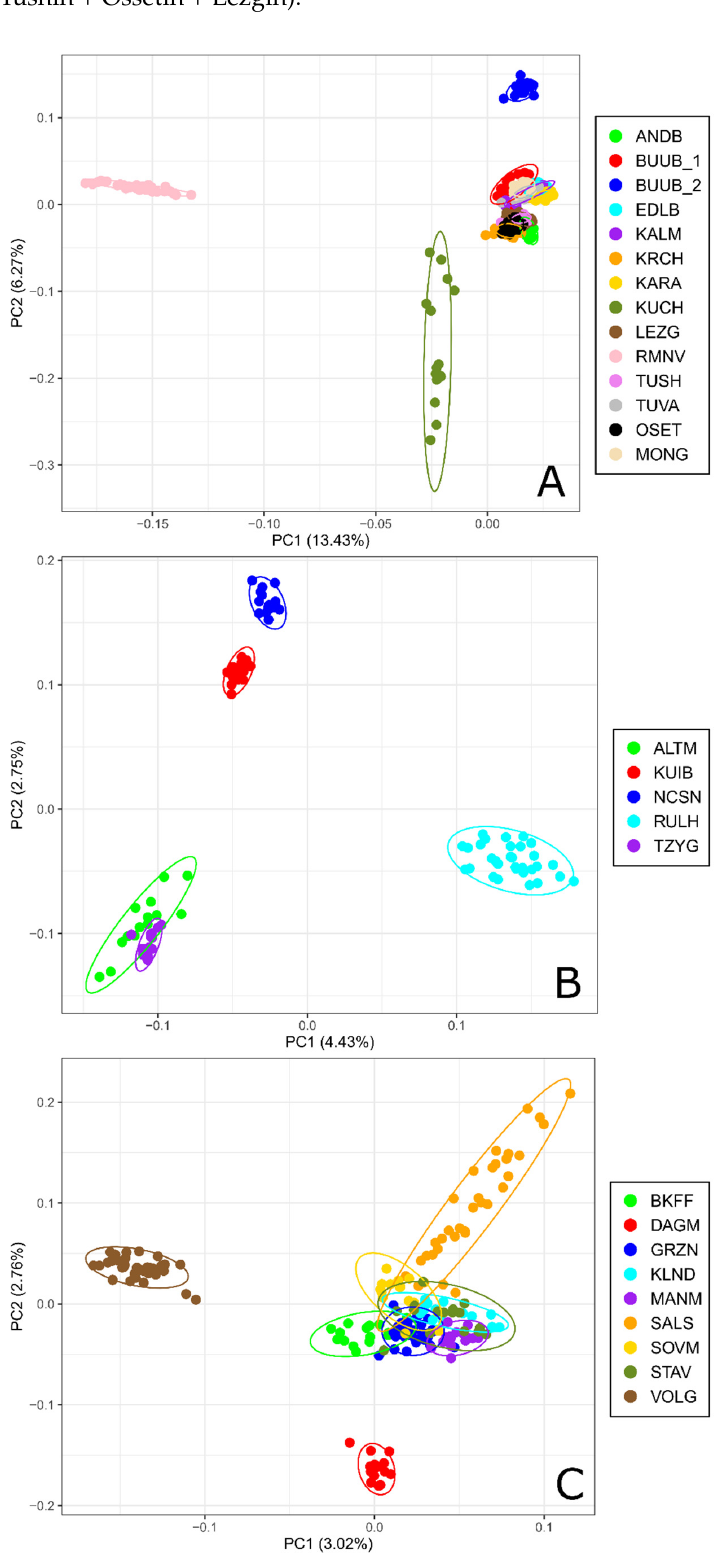
Figure 1. Principal component analysis for Russian sheep populations: ( A ) performed for coarse wool breeds; ( B ) performed for semi-fine wool breeds; ( C ) performed for fine wool breeds. For a description of the sheep breeds, see Table 1.